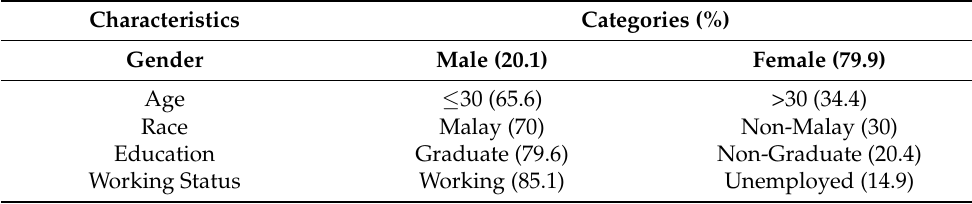
Table 1. Summary of demographic information of the